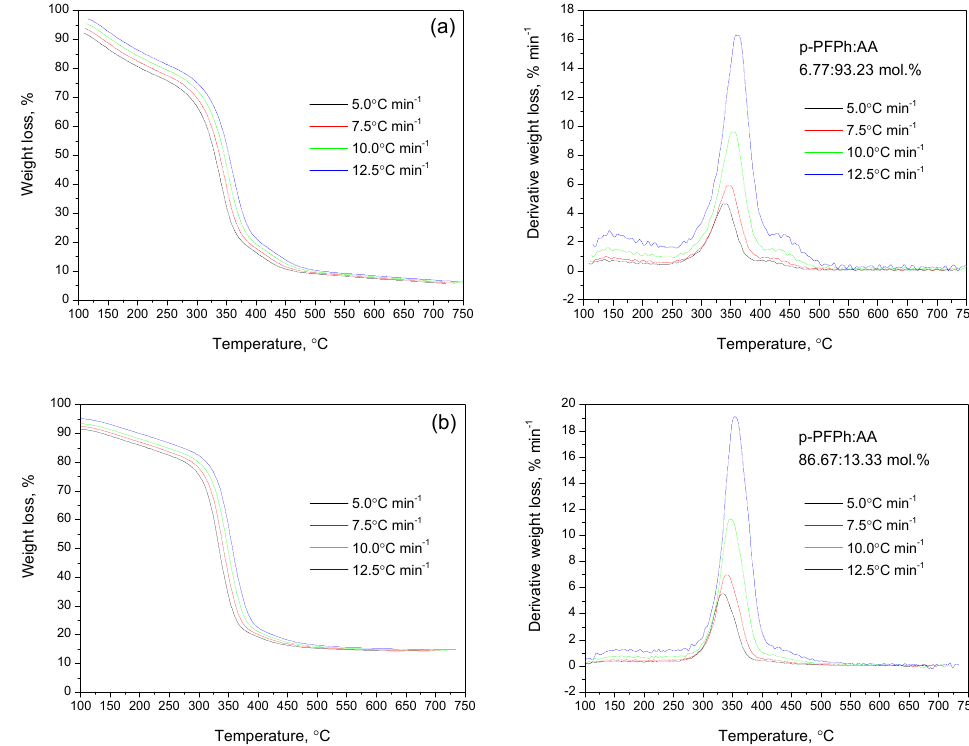
Figure 2. TG and dTG curves of p-PGFPh:АА copolymers at initial ratios М 1 :М 2 , mol.%: ( a )—6.77:93.23 and ( b )—86.67:13.33 (in nitrogen atmosphere). As shown in Figure 2а, p-PGFPh:АА (6.77:93.23) copolymer sample in nitrogen starts decomposing at ~100 °С. Then up to ~150 °С minor sample decomposition with highly volatile substances yield can be seen. The main stage of p-PGFPh:АА (6.77:93.23) copoly- mer thermal decomposition occurs between ~250 °С and ~450 °С. After this sample, mass stabilization can be seen. Mass loss speed (Figure 2b) at a heating rate increase changes between 5 °С/min and 12.5 °С/min. Charts clearly show curve shifts to a higher tempera- ture area, and this is shown by the mass loss peak shape (Figure 2b) of p-PGFPh:АА (86.67:13.33) copolymer. They have symmetrical sides which suggest a complex copoly- mer decomposition mechanism; its main stages occur due to ester link disruption, which is unstable at 300 °С. Some volatile substances can be determined by a specific strong peak of IR radiation absorption, where pyrolysis products in gas form are mainly CO 2 (2300 сm −1 ) and C=O (1720 сm −1 ). This conclusion is also proven by IR spectrometric analysis results. In the IR spectrum (Figure 3а) of p-PGFPh:АА (6.77:93.23) copolymer decomposi- tion products, there is a wide line with a maximum at 1719.11 сm −1 which belongs to va- lence vibrations of the C=O carbonyl groups. There is also an absorption band 2944.55 сm −1 of valence vibrations of С–Н linkages in СН- and СН 2 -groups as well as absorption bands with 1450, 1155, 1060 сm −1 of deformation vibrations of С–Н linkages in С–О and С–О–С groups. p-PGFPh:АА (86.67:13.33) copolymer thermal decomposition occurs similarly, ex- cept that in the recorded IR spectrum of p-PGFPh:АА (86.67:13.33) copolymer decompo- sition at temperatures between 400 and 600 °С CO 2 groups (2360 сm −1 ), valence vibrations line intensity increases. Thermograms and IR spectra are given in the Supplementary Ma- terials, Figure S1.